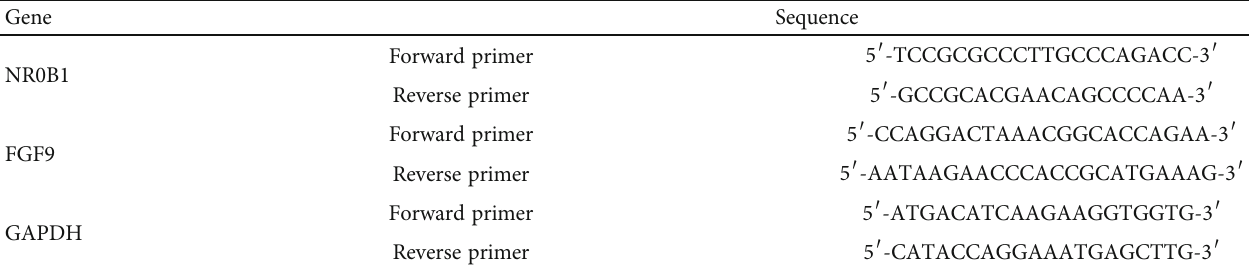
Table 1: Primer sequences for